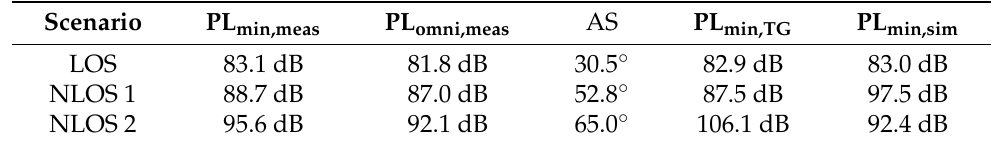
Table 3. Summary of measurement and simulation results for the different scenarios, with PL min,meas the minimum measured PL, PL omni,meas the omnidirectional measured PL, AS the measured angular spread, PL min,TG the minimum measured PL using the TG platform, and PL min,sim the minimum simulated